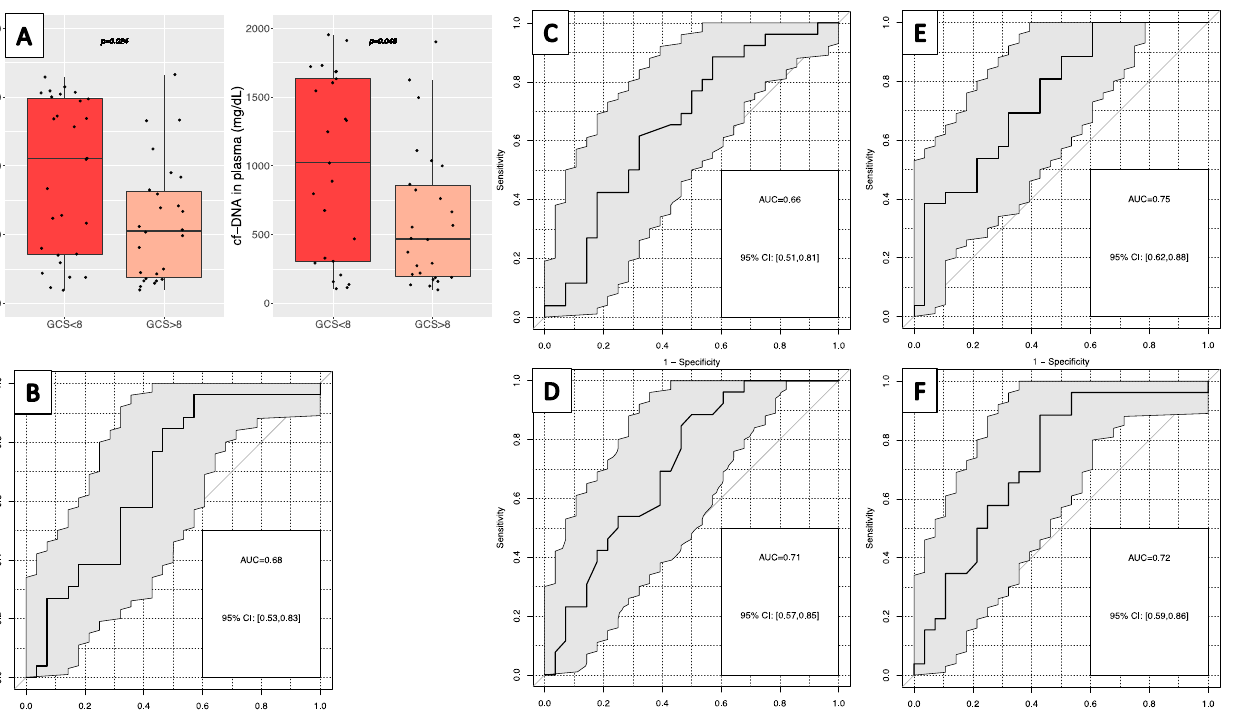
Figure 6. Decision tree for differentiation of all disease groups: group 1 = severe multiple trauma, group 2 = moderate multiple trauma; group 3 = femur neck fracture; group 4 = ankle fracture. hb1 (hemoglobin); cfdnas1 (cfDNA in serum); thrombo1 (platelets).